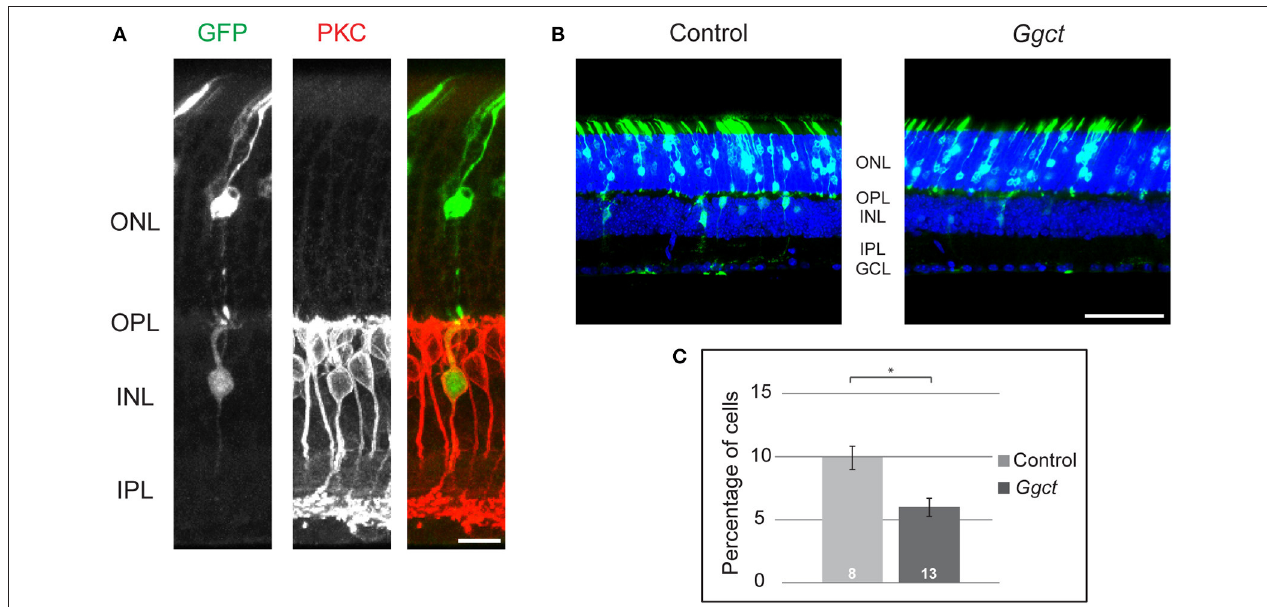
FIGURE 5 | (A) Control plasmids electroporated at P2 produced GFP + cells (green) in the ONL and INL at P21, including some RBCs that were evidenced by their PKC + status (red). (B) Ggct -encoding and control plasmids electroporated at P2 produced GFP + cells in both the ONL and INL at P21. Note the relative dearth of GFP + cells in the INL relative to the control condition. (C) The frequency of GFP + cells in the outer part of the INL was reduced by nearly 50% following electroporation of Ggct -encoding plasmids. n = the number of mice analyzed in the two conditions. Scale bar: (A) = 10 µ m; (B) = 50 µ m. * p <